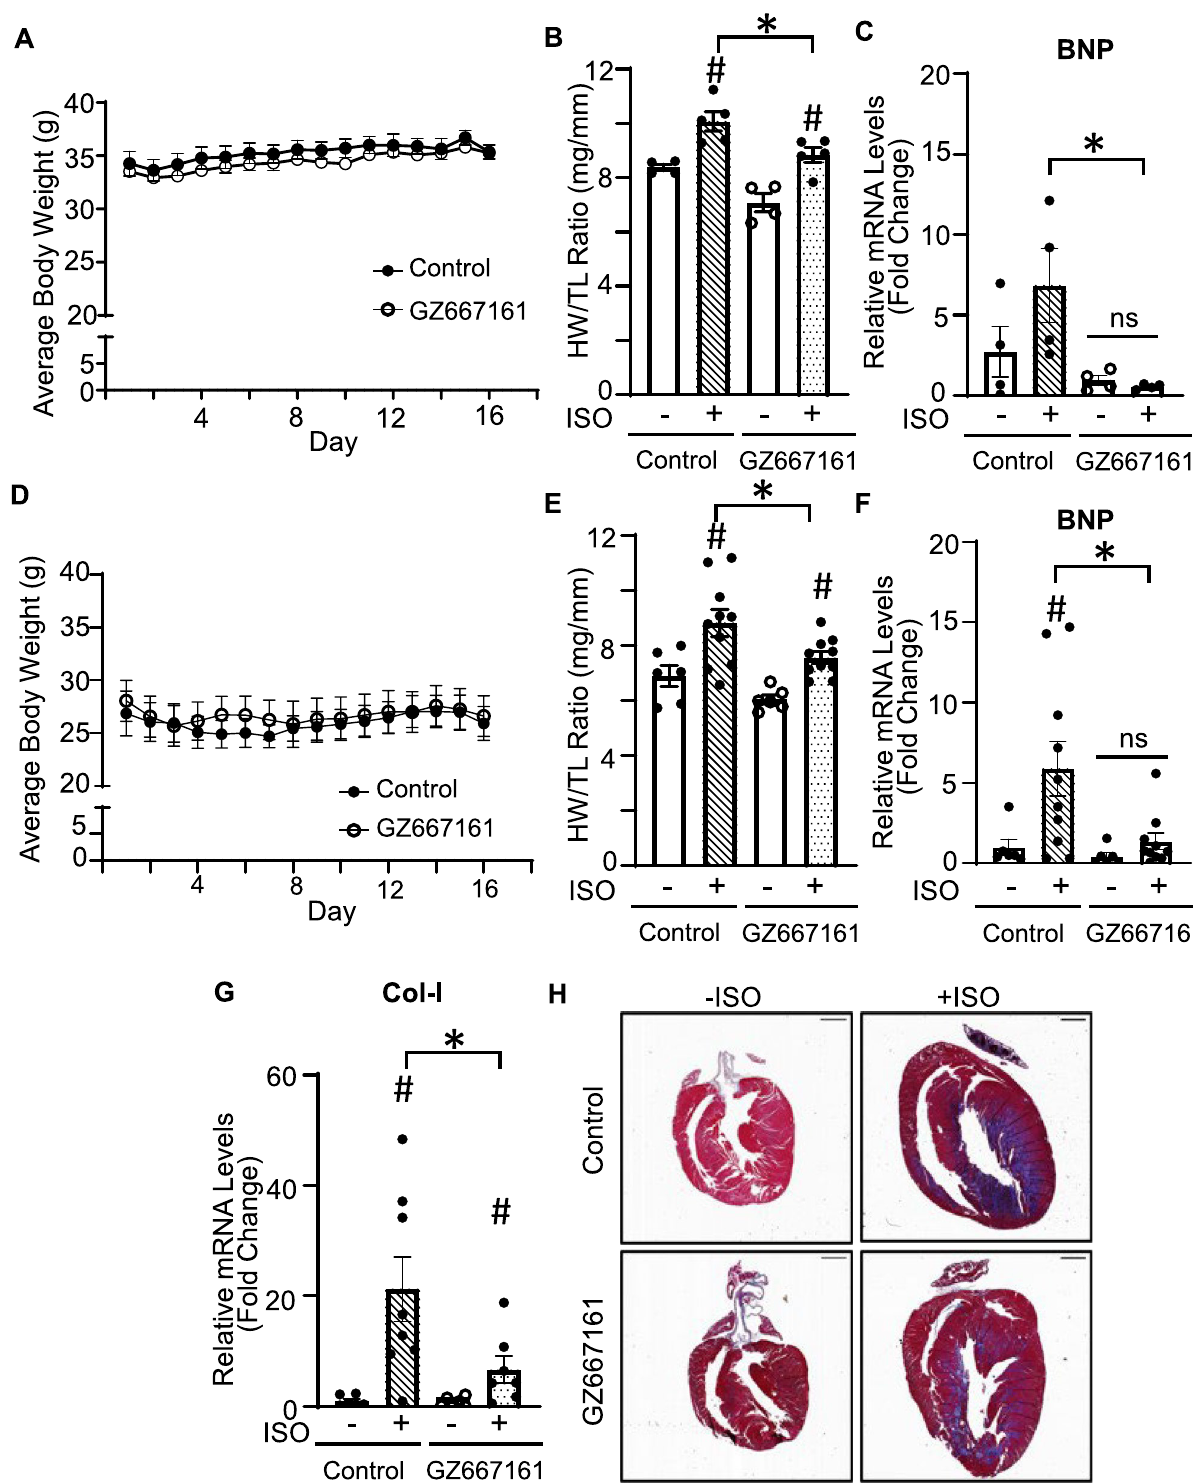
Figure 5. Gavage feeding GZ667161 at a dose of 20 mg/kg does not cause BW loss yet protects the heart. ( A – D ) Mice were treated with or without ISO to induce cardiac stress to investigate the role of GZ667161. ( A ) BW time course for treatment with 20 mg/kg GZ66761 through gavage feeding. ( B ) HW/TL ratio. ( C ) Reduction of cardiac remodeling gene BNP. (n = 4–5 per group) ( D – G ) Dietary feeding GZ667161 (0.11% wt/wt) provides cardioprotection in ISO- induced model of cardiac stress. Mice were treated with or without ISO to induce cardiac stress to investigate the role of GZ667161. ( D ) Body weight time course for treatment with 0.011% GZ667161 diet. ( E ) HW/TL ratio of mice fed with 0.011% GZ667161 diet. ( F ) BNP. ( G ) Col-I. ( H ) Trichrome staining for collagen fibers on +/− ISO treated mice. Scale bar is 1 mm. + ISO (n = 10 per group). − ISO (n = 6 per group). # P < 0.05 − ISO vs + ISO. * P < 0.05 between indicated groups. ns, not significantly different between indicated groups. Data is expressed as mean ±